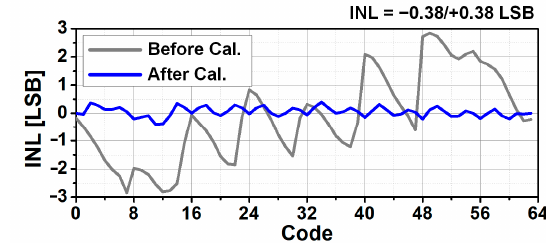
Figure 14. Measurement setup. The measured differential non-linearity (DNL) and integral non-linearity (INL) profiles before and after the offset calibration for the coarse comparators and fine VTCs and the gain calibration for the four-channel THAs calibrated in the digital domain are shown in Figure 15. The peak DNL and INL improved from +3.28/ − 0.64 LSB and +2.84/ − 2.84 LSB to +0.45/ − 0.31 LSB and +0.38/ − 0.38 LSB, respectively.